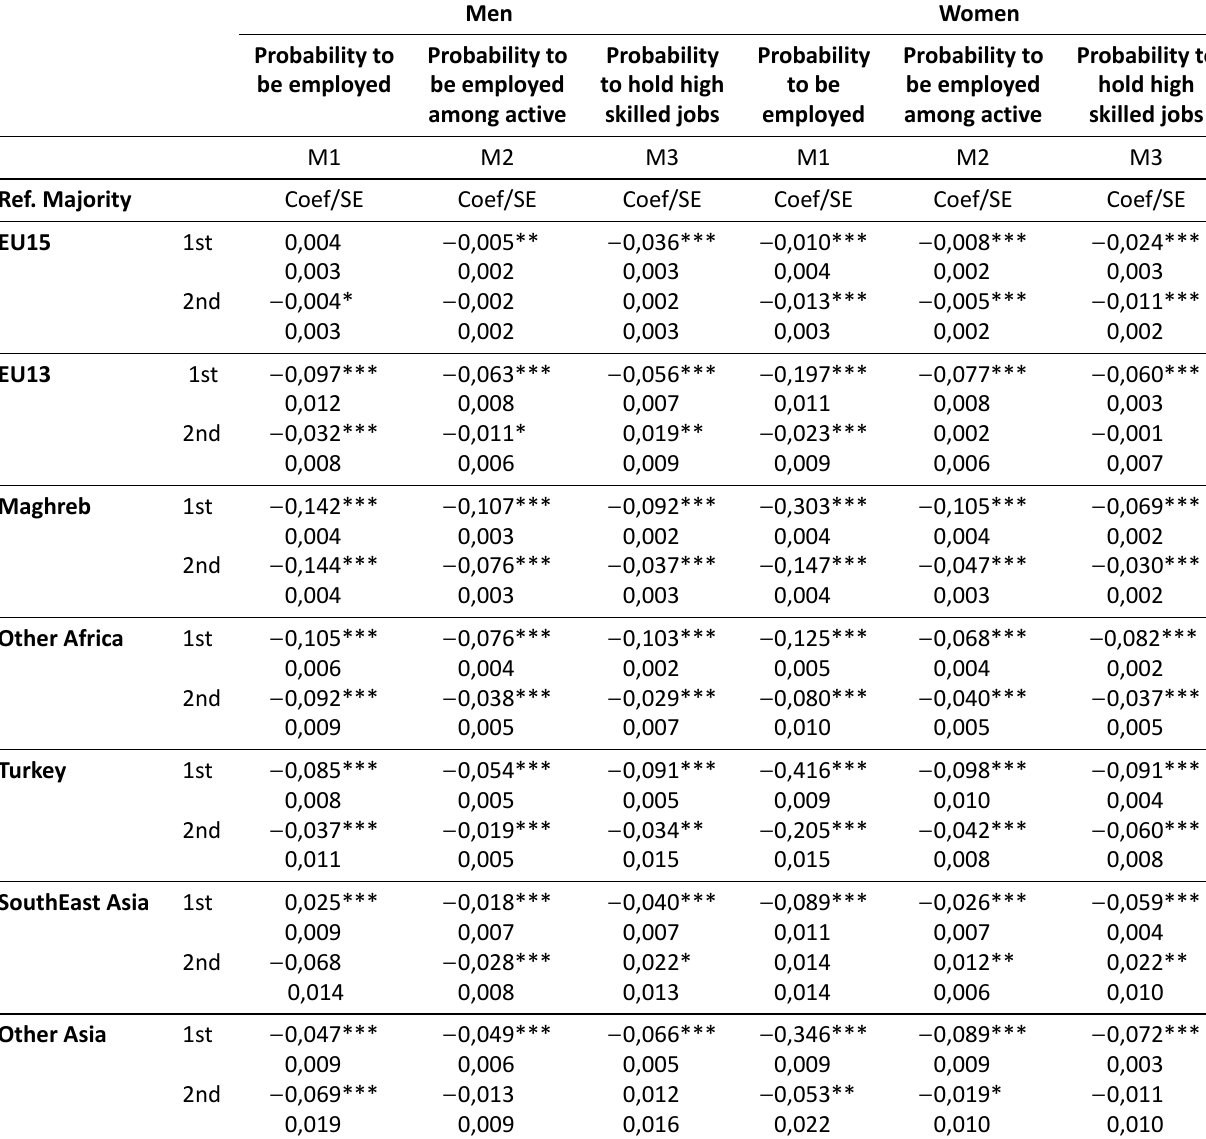
Table 2. Estimated gaps in labour market outcomes from Majority population by gender. Source: INSEE Labour Force Survey 2013–2017, excluding people in education or in training.